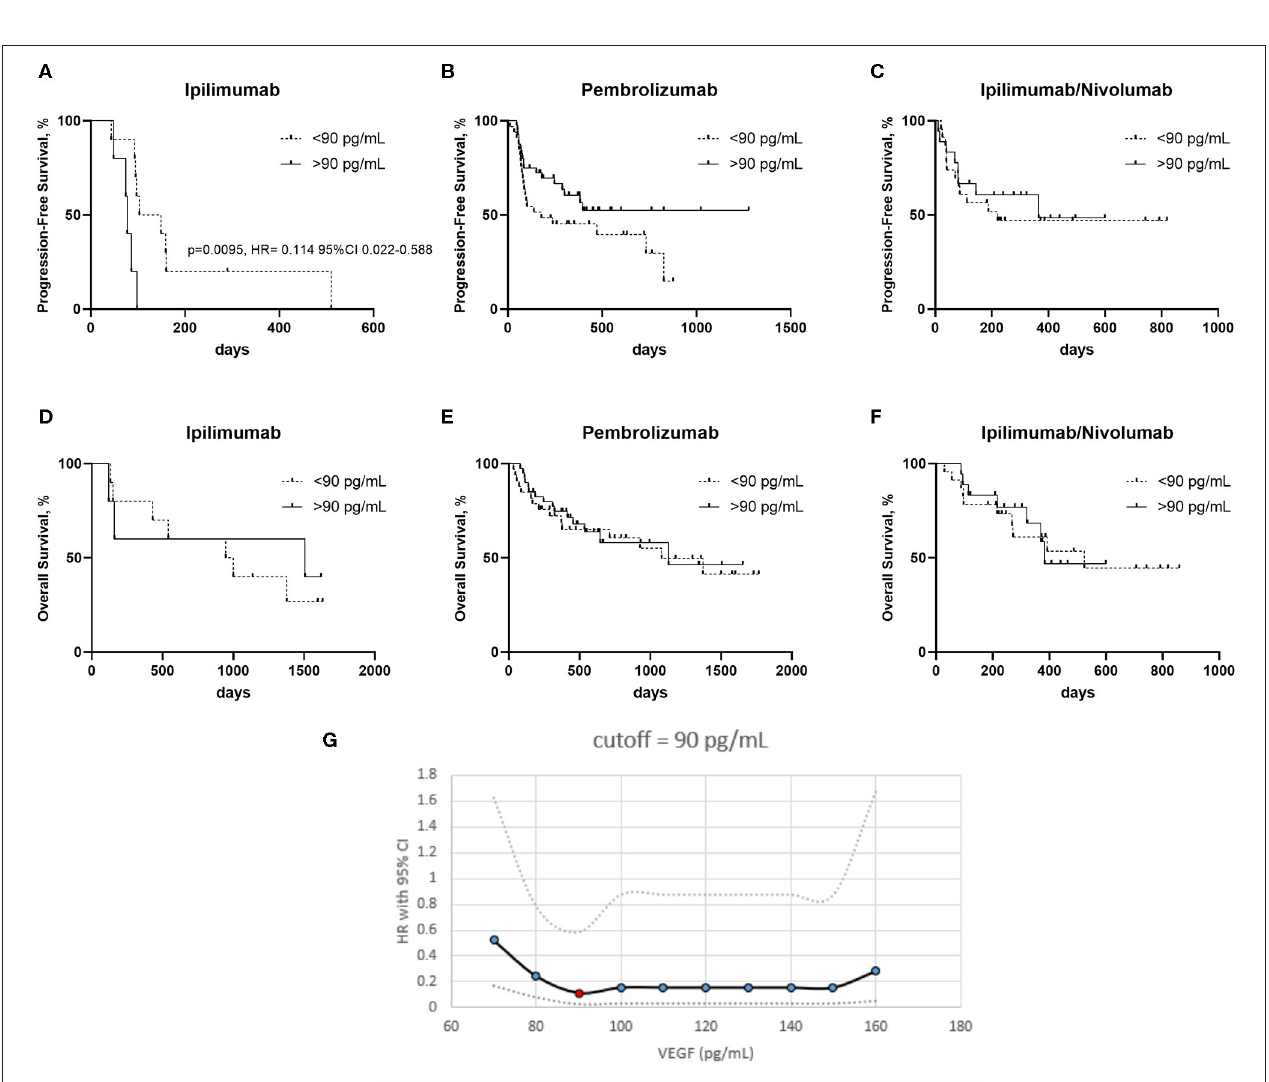
Frontiers in Oncology | www.frontiersin.org